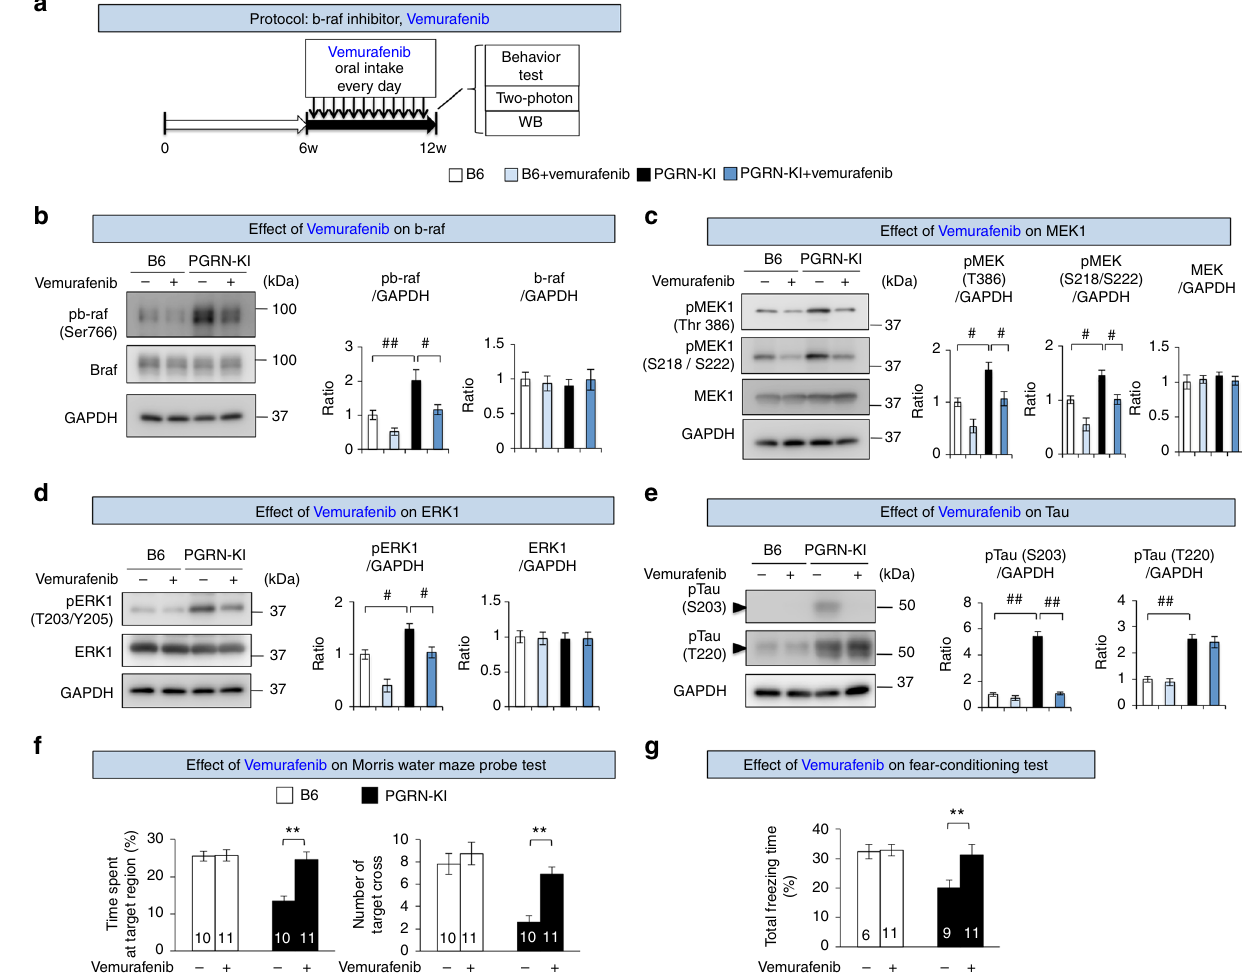
Fig. 6 Vemurafenib rescues phosphorylation signals and phenotypes in PGRN-KI mice. a Experimental protocol for administration of B-Raf inhibitor (vemurafenib). The mice were fed vemurafenib (32 mg/kg of BW/day) or mock from 6 to 12 weeks of age. Behavioral tests and western blots were performed at 12 weeks. b In vivo effect of vemurafenib on B-Raf phosphorylation in cortical tissues of PGRN-KI mice. # p < 0.05; ## p < 0.01 ( N = 6, Tukey ’ s HSD test). Averages and s.e.m. are shown. c In vivo effect of vemurafenib on MEK phosphorylation in cortical tissues of PGRN-KI mice. # p < 0.05 ( N = 6, Tukey ’ s HSD test). Averages and s.e.m. are shown. d In vivo effect of vemurafenib on ERK phosphorylation in cortical tissues of PGRN-KI mice. # p < 0.05 ( N = 6, Tukey ’ s HSD test). Averages and s.e.m. are shown. e In vivo effect of vemurafenib on phosphorylation of tau in cortical tissues of PGRN-KI mice. Right panels show quantitation of western blot band intensities. ## p < 0.01 ( N = 6, Tukey ’ s HSD test). Averages and s.e.m. are shown. f In vivo effect of vemurafenib on two parameters (% time spent at target region and number of target crosses) in the Morris water maze test. Numbers of mice are shown in the graph. ** p < 0.01 (Student ’ s t -test). Averages and s.e.m. are shown. g Effect of vemurafenib on % total freezing time in the fear-conditioning test. Numbers of mice are shown in the graph. p -values were determined by Student ’ s t -test. Averages and s.e.m. are